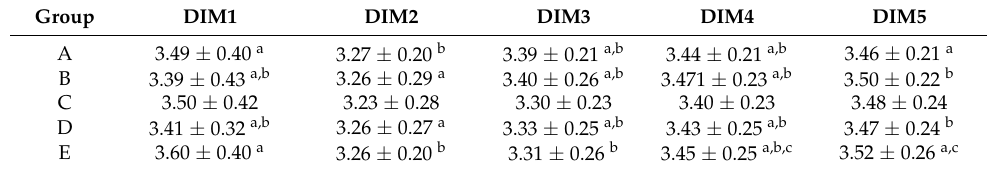
Table 4. Milk protein content in milk (%) pattern by group over the first five months of lactation.